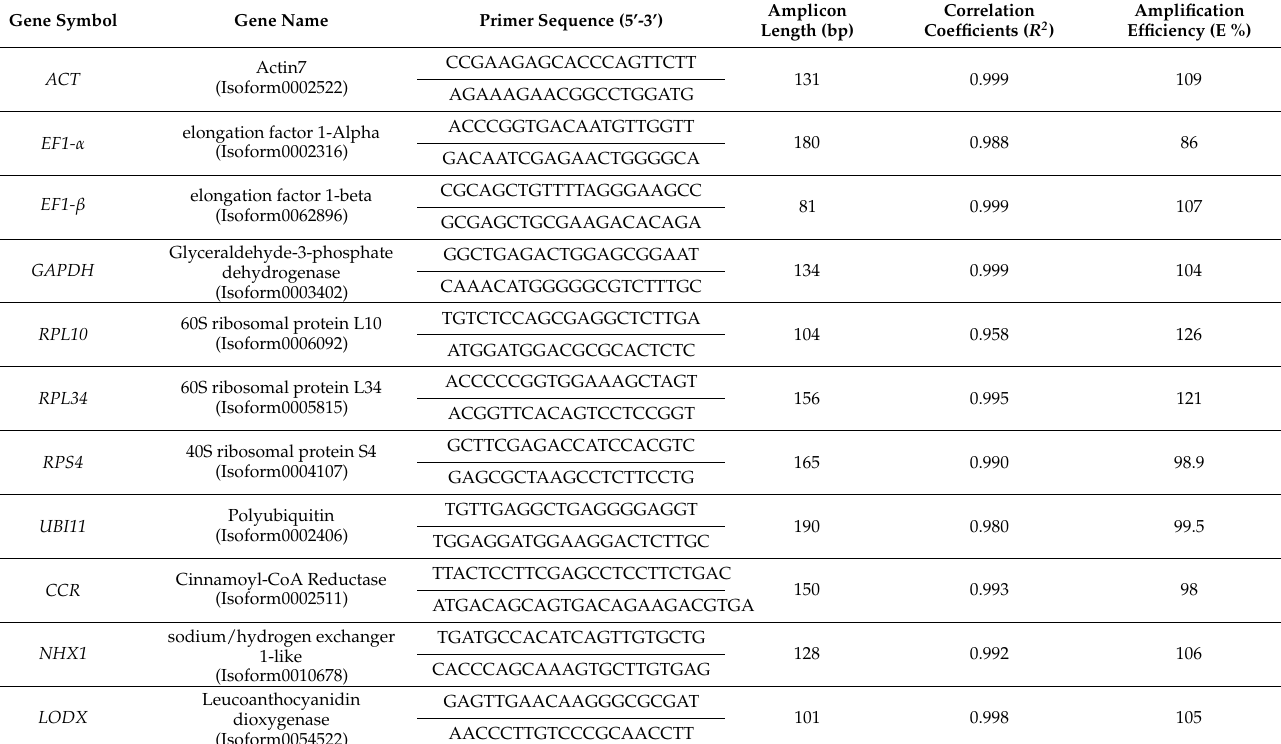
Table 2. Introduction of candidate reference genes and target